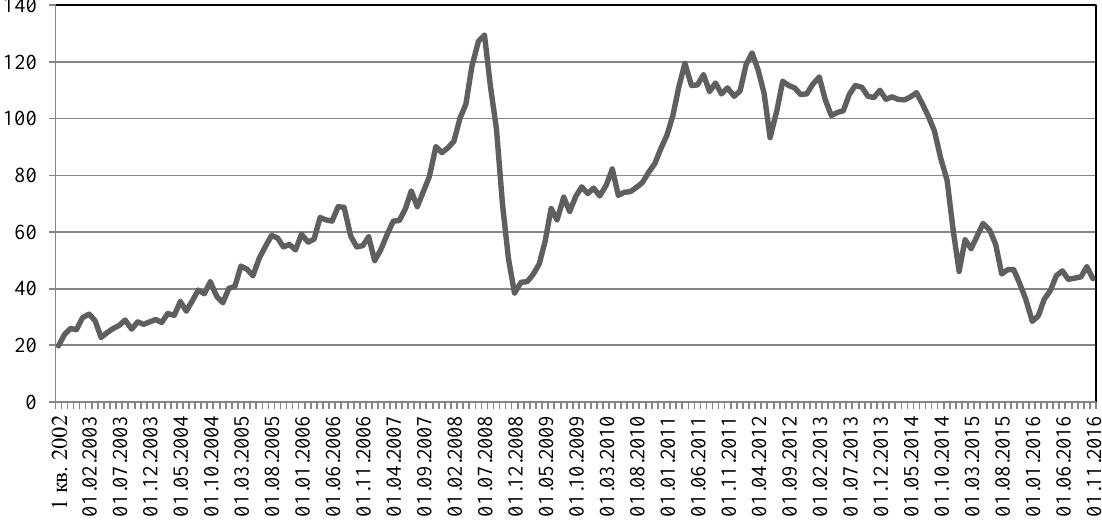
Fig. 8. Price dynamics for the Urals crude oil for 2002–2016, $/per barrel (compiled by authors to: [21]).